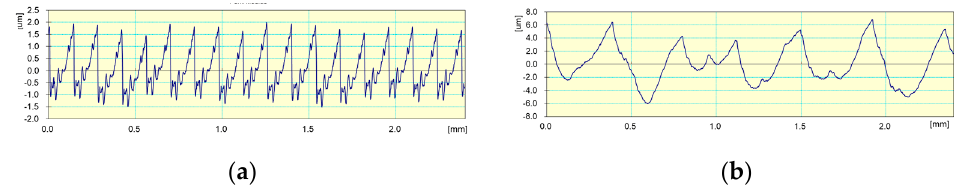
Figure 7. Roughness profile of the workpiece when cutting with a carbide boring bar: ( a ) in stable conditions at TSC = 4 mm − 1 ; ( b ) in unstable conditions at TSC = 21.43 mm − 1 .